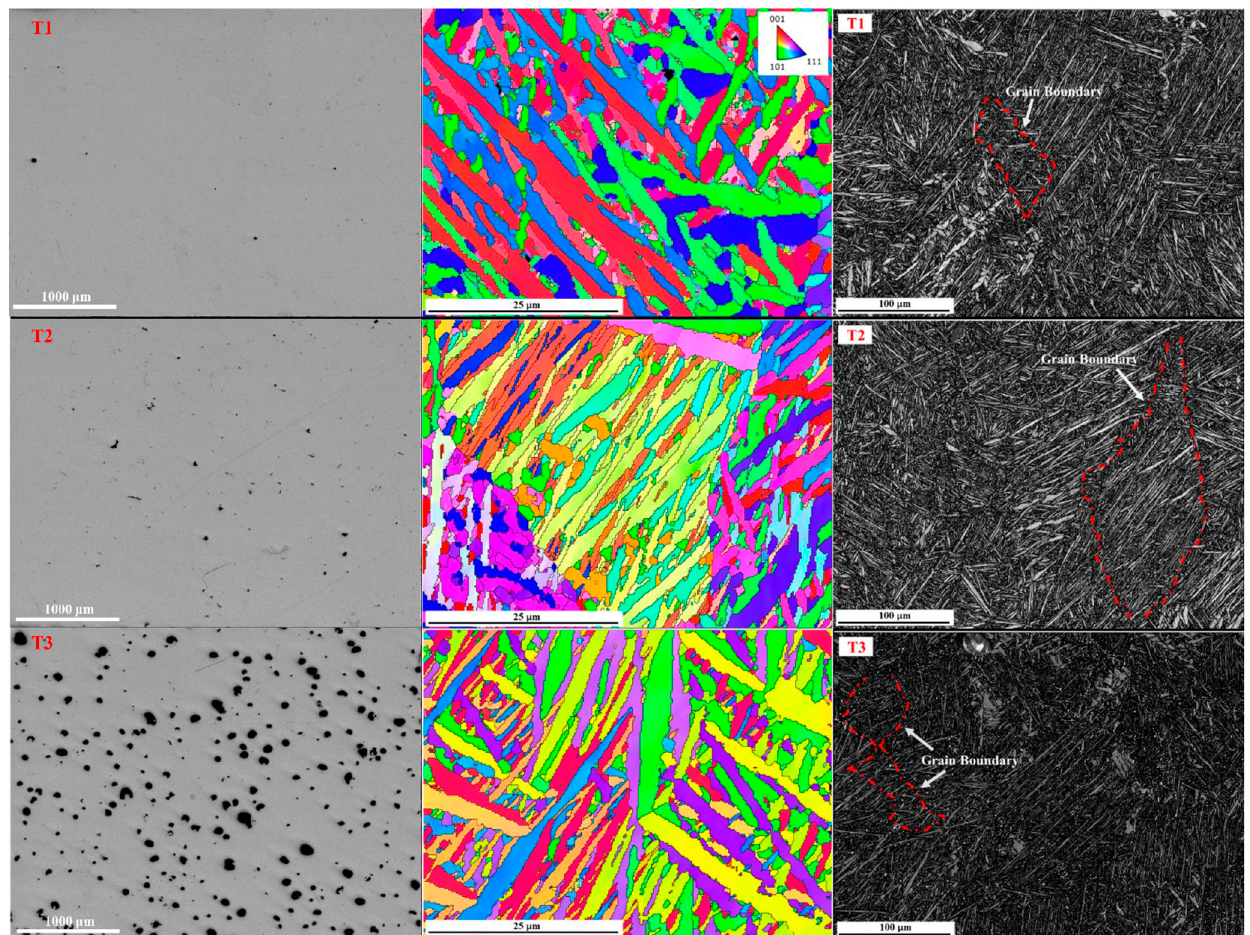
Figure 2. Optical microscopy ( left ), EBSD ( middle ), and band ‐ contrast images ( right ) of the SLM Ti ‐ 6Al ‐ 4V materials studied. Top view: sample T1 of porosity 0.29%; middle view: sample T2 of porosity 0.88%; bottom view: sample T3 of porosity 5.41%.